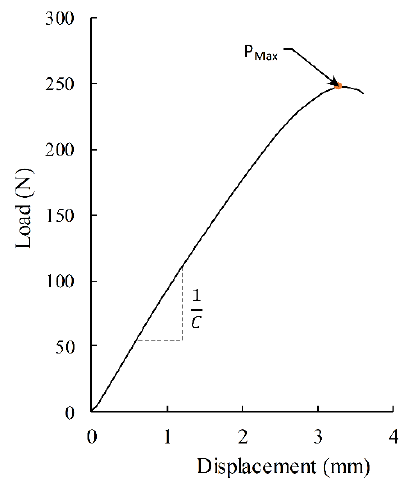
Figure 11. Load-displacement curve of ENF test and illustration of compliance ( C ) and P Max determination.